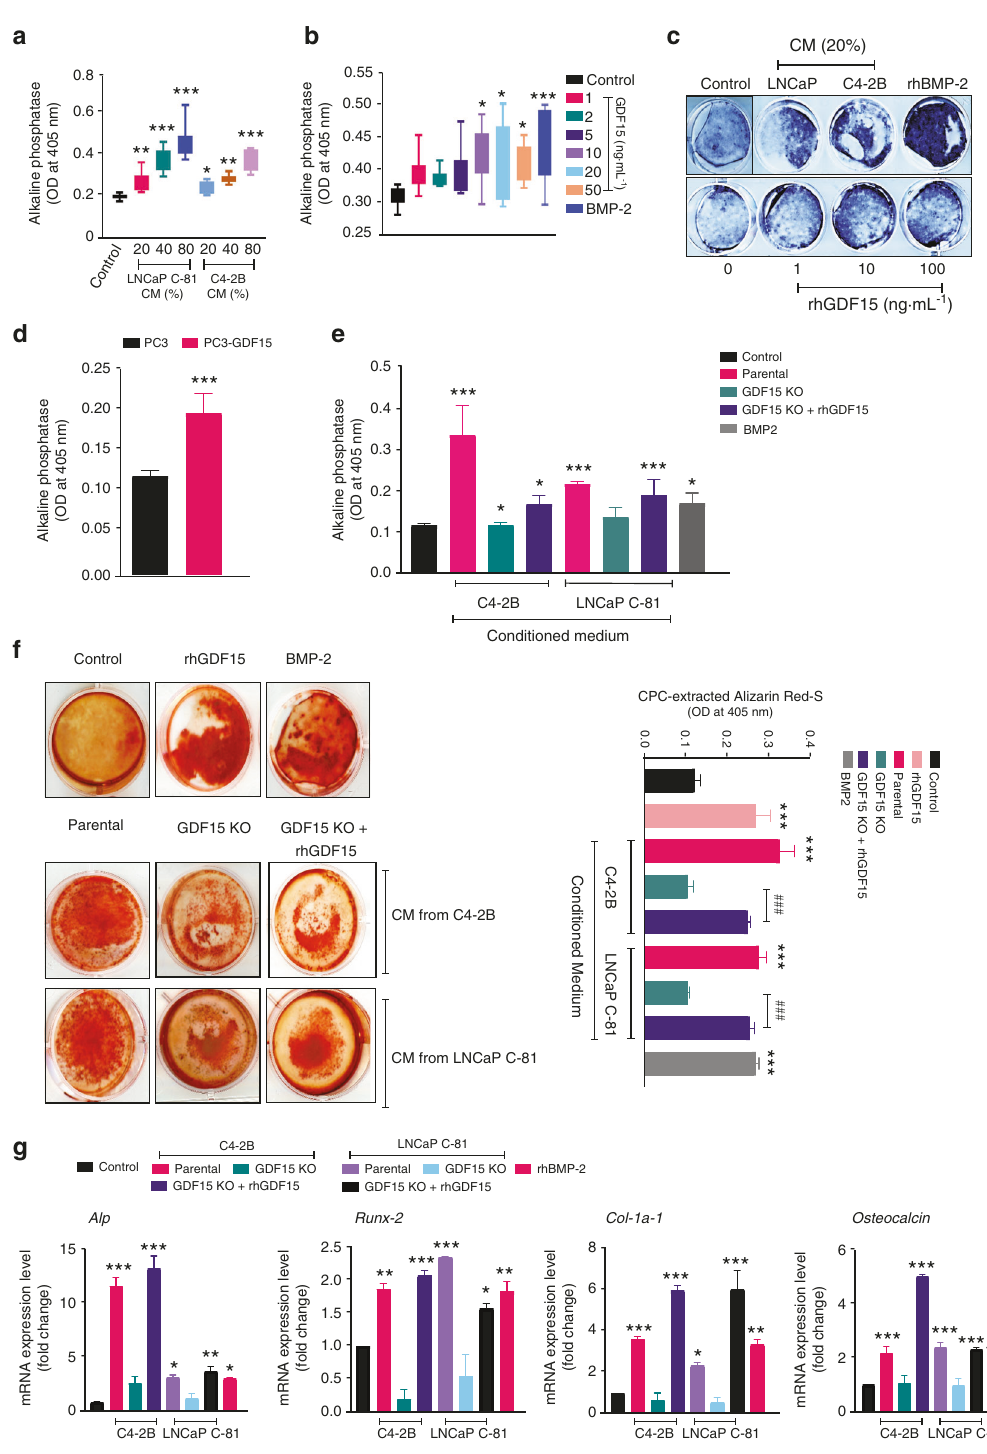
Fig. 4 PCa-secreted GDF15 augments osteogenic activity. a PCa factors promote osteoblast differentiation, as measured by alkaline phosphatase assay. MCOs were treated with different proportions of conditioned medium (CM 20%, 40%, and 80%) from the LNCaP C-81 and C4-2B cell lines (after 48h of treatment) and subjected to alkaline phosphatase activity analysis. b Treatment with rhGDF15 for 48h increased osteoblast differentiation, as determined by measuring alkaline phosphatase activity. c Representative alkaline phosphatase staining of MCOs after 10 days of treatment with the CM of LNCaP C-81 and C4-2B cells and different doses of rhGDF15. d, e Osteoblast differentiation (alkaline phosphatase activity) after 48h of treatment with d CM obtained from PC3 and PC3 cells overexpressing GDF15 and e CM from C4-2B and LNCaP C-81 cells. f Assessment of mineralized nodules using alizarin red-S dye staining. MCOs were treated with the control, 20% CM from PCa cell lines, and/or rhGDF15 for 21 days, and the osteoblast differentiation medium was replaced every third day. The left panel shows representative alizarin red-S-stained nodules, and the right panel shows quanti fi cation of alizarin red-S staining with cetylpyridinium chloride (CPC) extraction. g MCOs were treated with the control or 20% CM from PCa cell lines and/or rhGDF15 for 72 h in osteoblast differentiation medium. Total RNA was harvested, RT – qPCR for osteogenic genes ( alkaline phosphatase: ALP, Runx-2, Col-1a, and osteocalcin) was performed, and gene expression was normalized to that of β -actin. The data represent the mean ±SEM from three independent experiments. P ≤ 0.05 was considered to indicate statistical signi fi